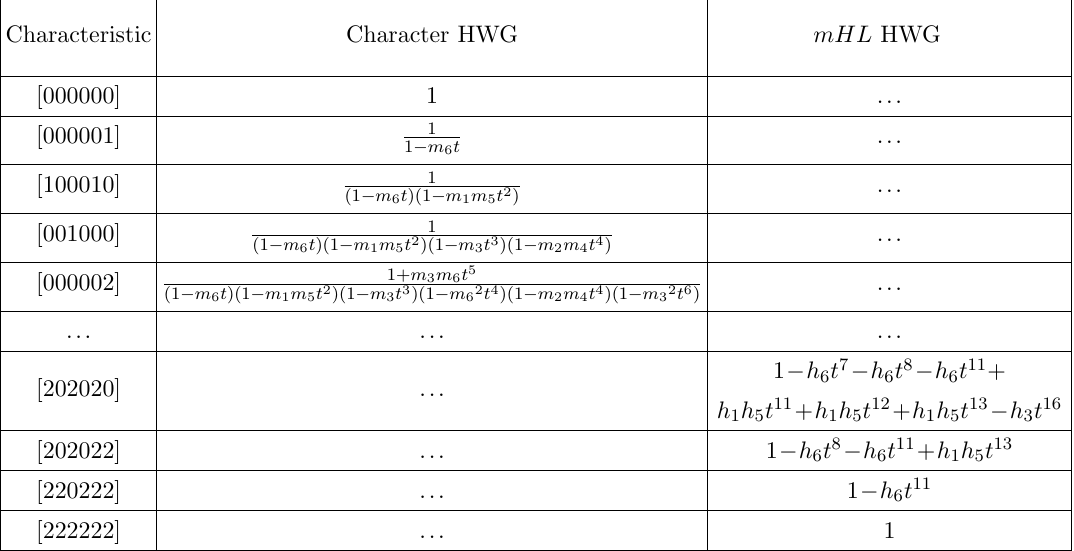
( t ). Orbits in the centre [000000]